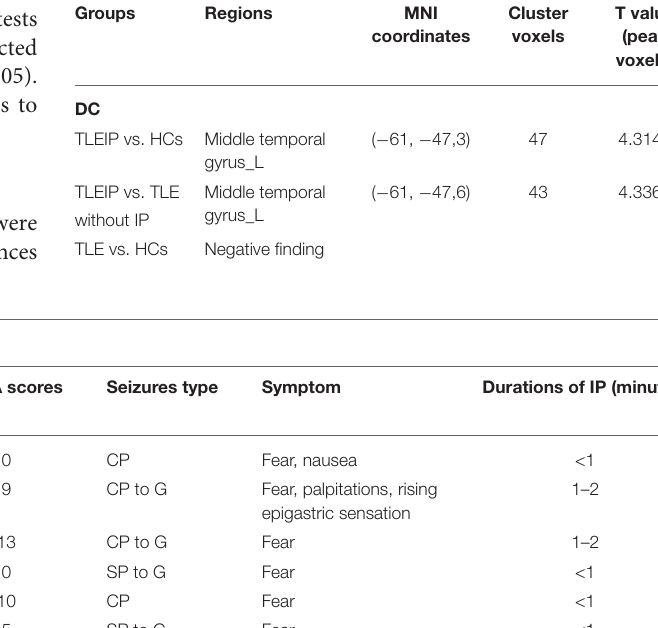
TABLE 3 | The degree centrality (DC) differences between the TLEIP group, TLE without IP group, and healthy control (HC) group. Groups